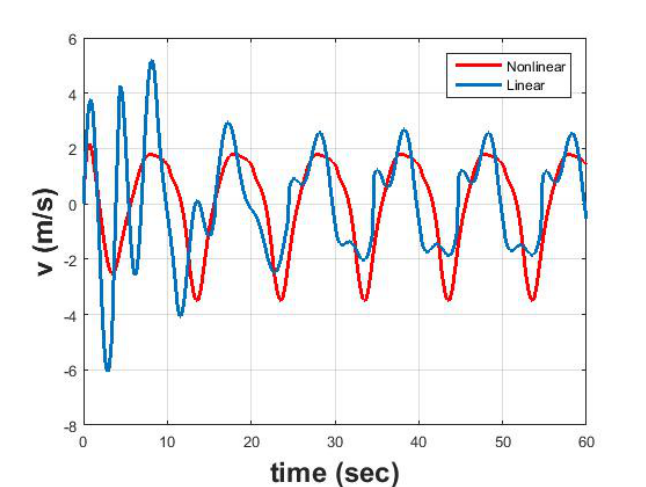
Figure 11. Comparison between the linear and nonlinear WECs in a regular wave: buoy velocity.